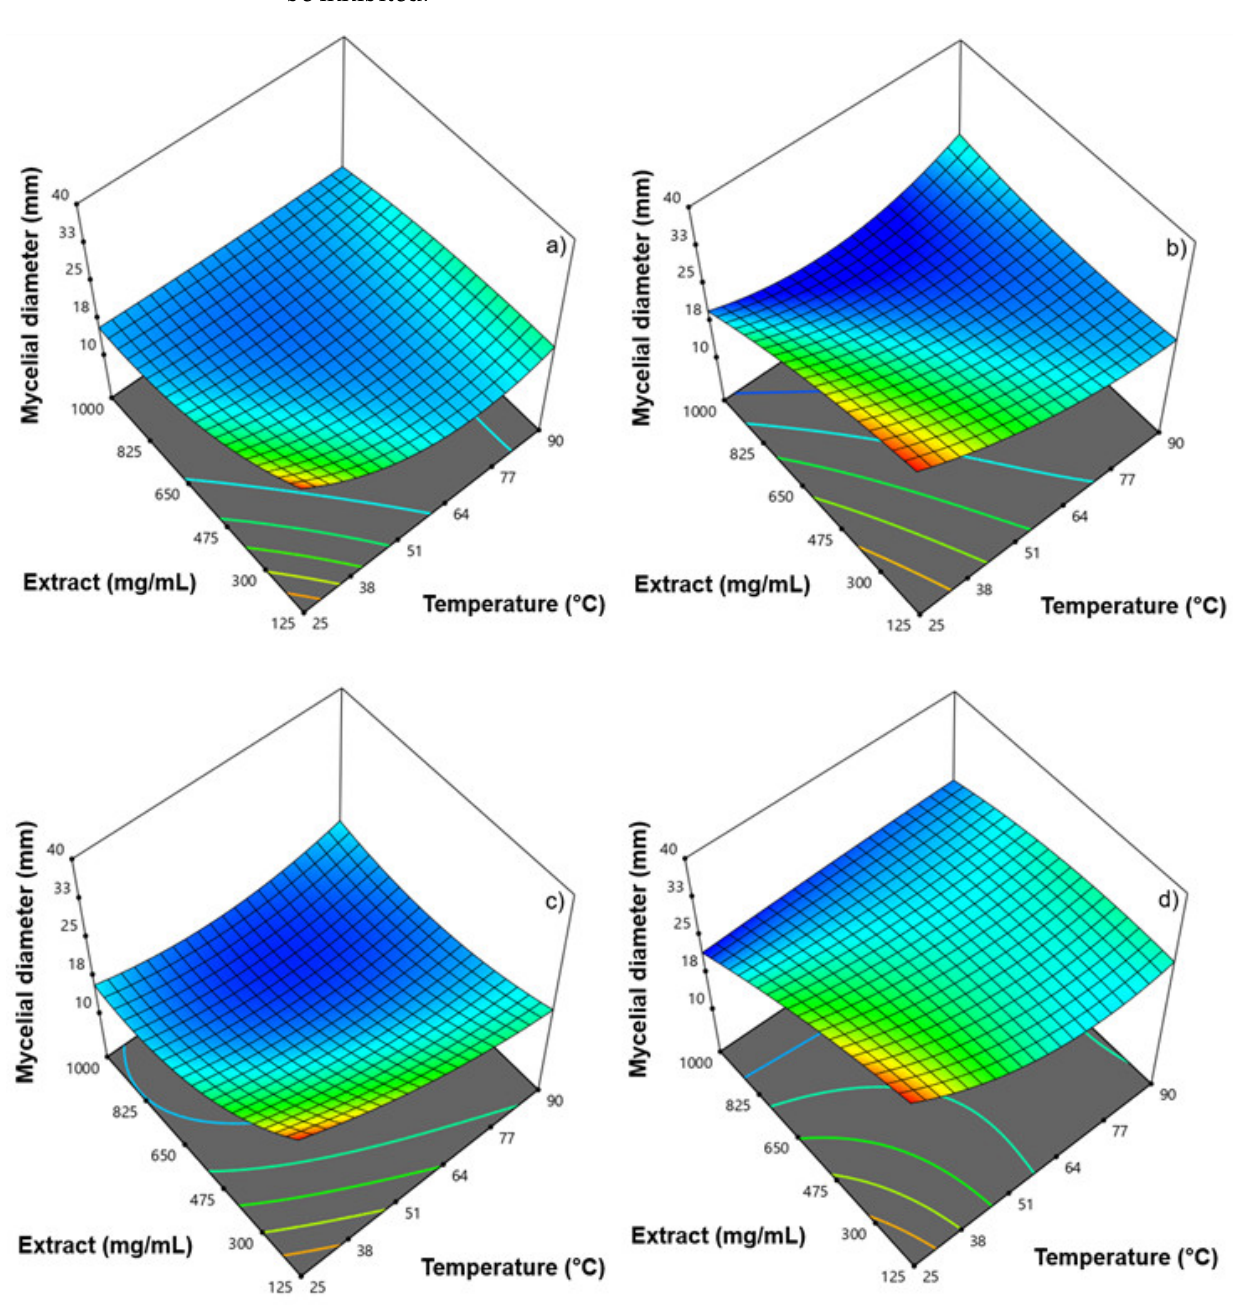
Figure 1. Antifungal activity of aqueous extracts at different concentrations and temperatures: ( a ) Summit MT / F. oxysporum (FS) hops, ( b ) Hull Melon Germany MT / F. oxysporum (FM) hops, ( c ) Sum- mit MT / A. solani (AS) hops, ( d ) Hull Melon Germany MT / A. solani (AM). Mycelium diameter (mm) in relation to the concentration and temperature of the aqueous extract.